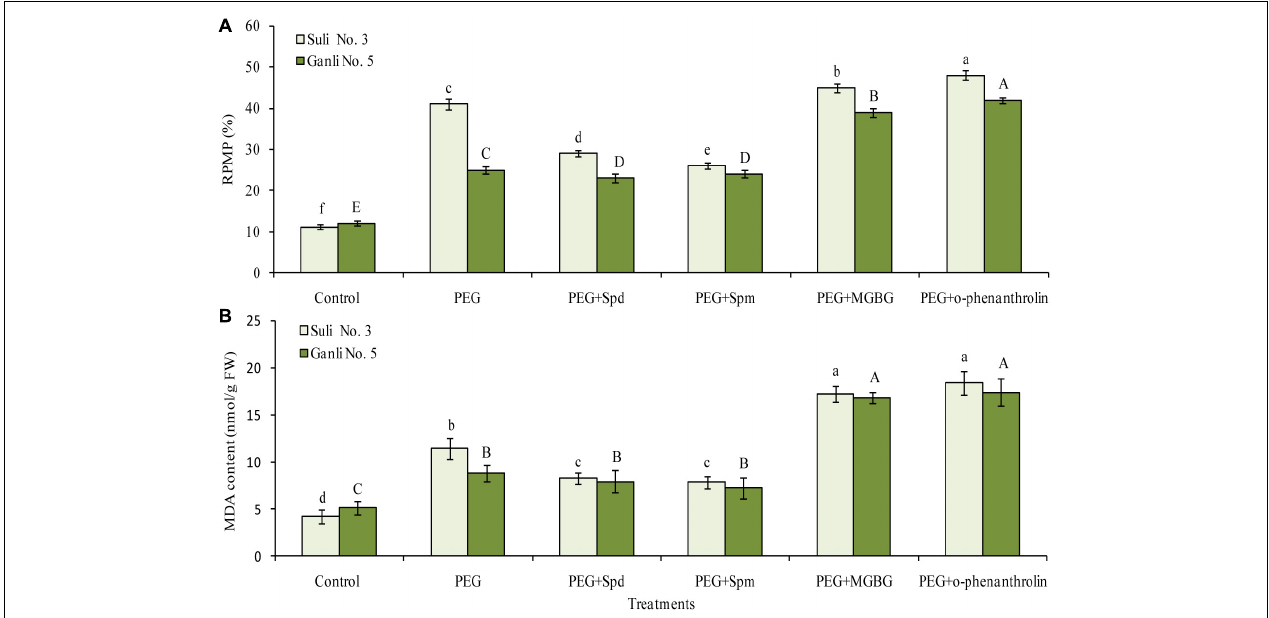
FIGURE 3 | Changes in RPMP (A) and the content of MDA (B) of plum seedling roots under PEG, exogenous Spd, Spm, MGBG, and o-phenanthroline. Control: treatment without PEG or the other reagents (–0.15 MPa); PEG: treatment with PEG (–0.85 MPa); PEG + Spd: treatment with PEG and Spd (1 mM); PEG + Spm: treatment with PEG and Spm (1 mM); PEG + MGBG: treatment with PEG and MGBG (0.5 mM); PEG + o-phenanthroline: treatment with PEG and o-phenanthroline (0.2 mM). The data here were means ( n = 9) ± standard error of 3 independent experiments. Significant differences between treatments are indicated with letters, with upper and lower letters for each cultivar ( P <